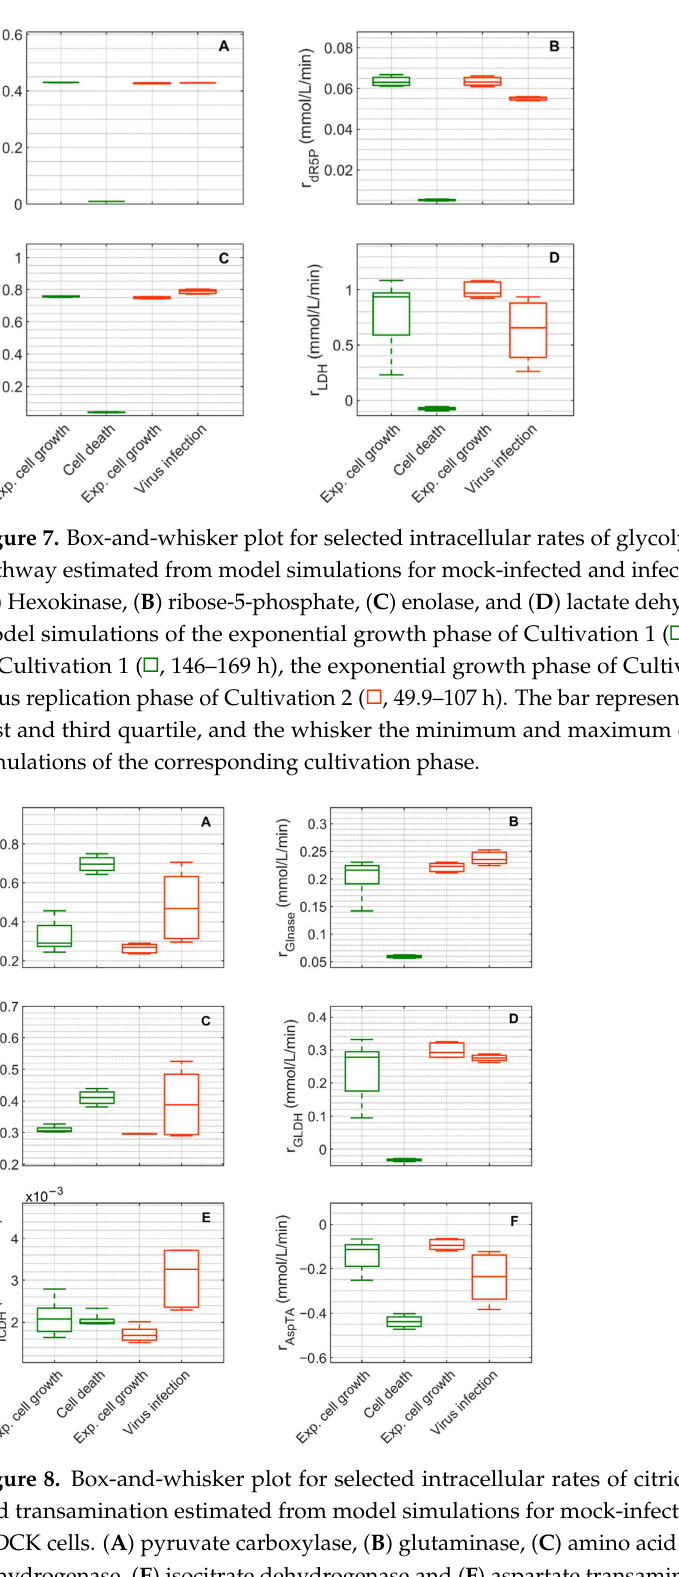
Figure 8. Box-and-whisker plot for selected intracellular rates of citric acid cycle, glutaminolysis and transamination estimated from model simulations for mock-infected and infected suspension